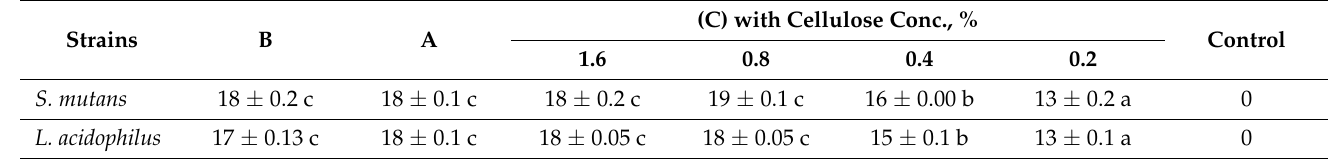
Figure 9. Antimicrobial activity of control, Ulva/nanocellulose, and Ulva/Ag/cellulose nanocom- posite at different concentrations of cellulose (0.1, 0.2, 0.4, and 0.8 g) against both ( A ) S. mutans ATCC 25175 (R1) and ( B ) L. acidophilus CH-2 (R2) Clear zones (11), control Ulva extract, (6) Ulva/nanocellulose, clear zone of different cellulose concentrations (0.1, 0.2, 0.4, and 0.8 g) of Ulva/Ag/cellulose nanocomposite (7, 8, 9, and 10), respectively. Table 3. Inhibition zone diameter (mm) of S. mutans ATCC 25175 and L. acidophilus CH-2 at different concentrations of cellulose percentage to form Ulva/Ag/cellulose nanocomposites, Ulva/AgNPs, and nanocellulose derived from U. lactuca